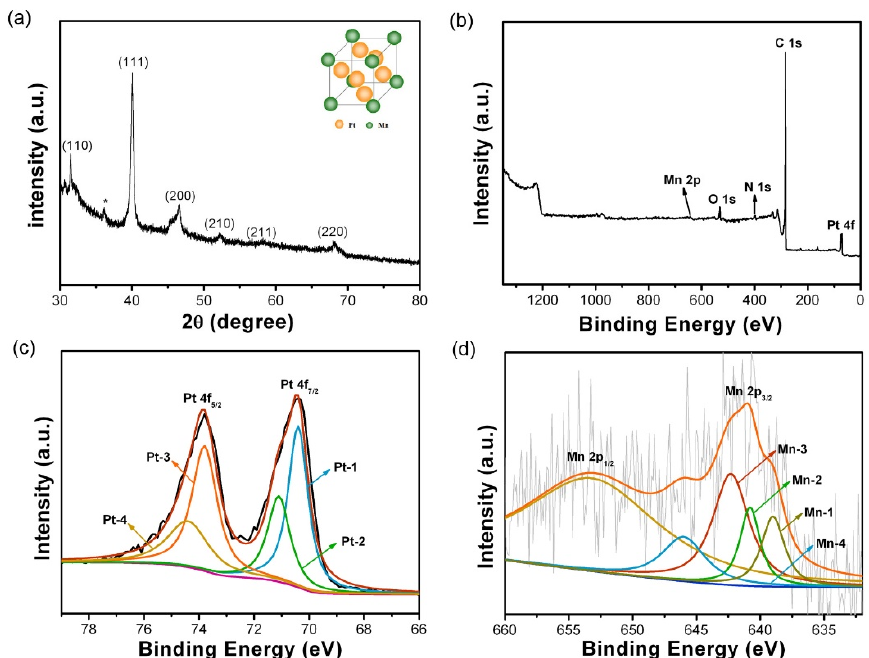
Figure 2. ( a ) XRD pattern and ( b ) XPS survey spectrum of PtMn ‐ 950/CNFs. Peak ‐ fitting XPS spectra of ( c ) Pt 4f and ( d ) Mn 2p 3/2 .